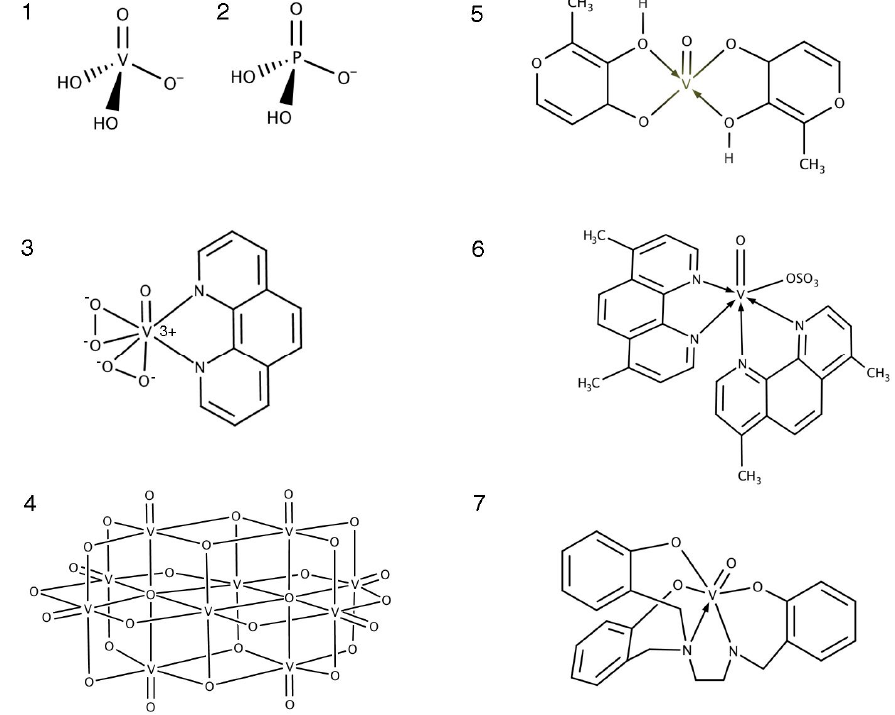
Figure 2. Structure 1 , orthovanadate; Structure 2 , phosphate; Structure 3 , bisperoxo(1,10- phenanthroline)oxidovanadate(V) (bpv-phen); Structure 4 , decavanadate (V10); Structure 5 , bis(maltolato)oxidovanadium (IV) (BMOV); Structure 6 , bis(4,7-dimethyl-1,10-phenanthroline) sulfatooxidovanadium(IV) (Metvan); Structure 7 , vanadium(V) oxo phenolato complex [25].